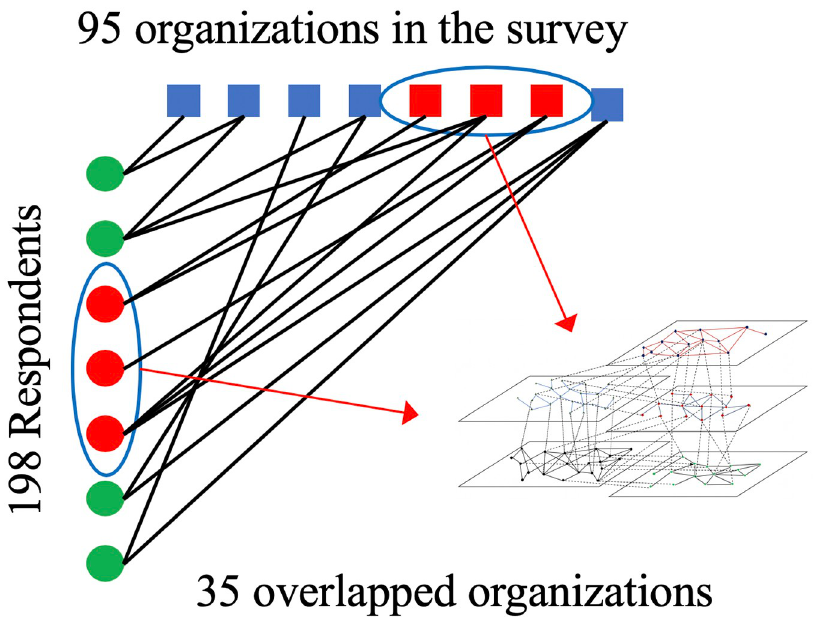
Fig 2. The collaboration network of 35 organizations.